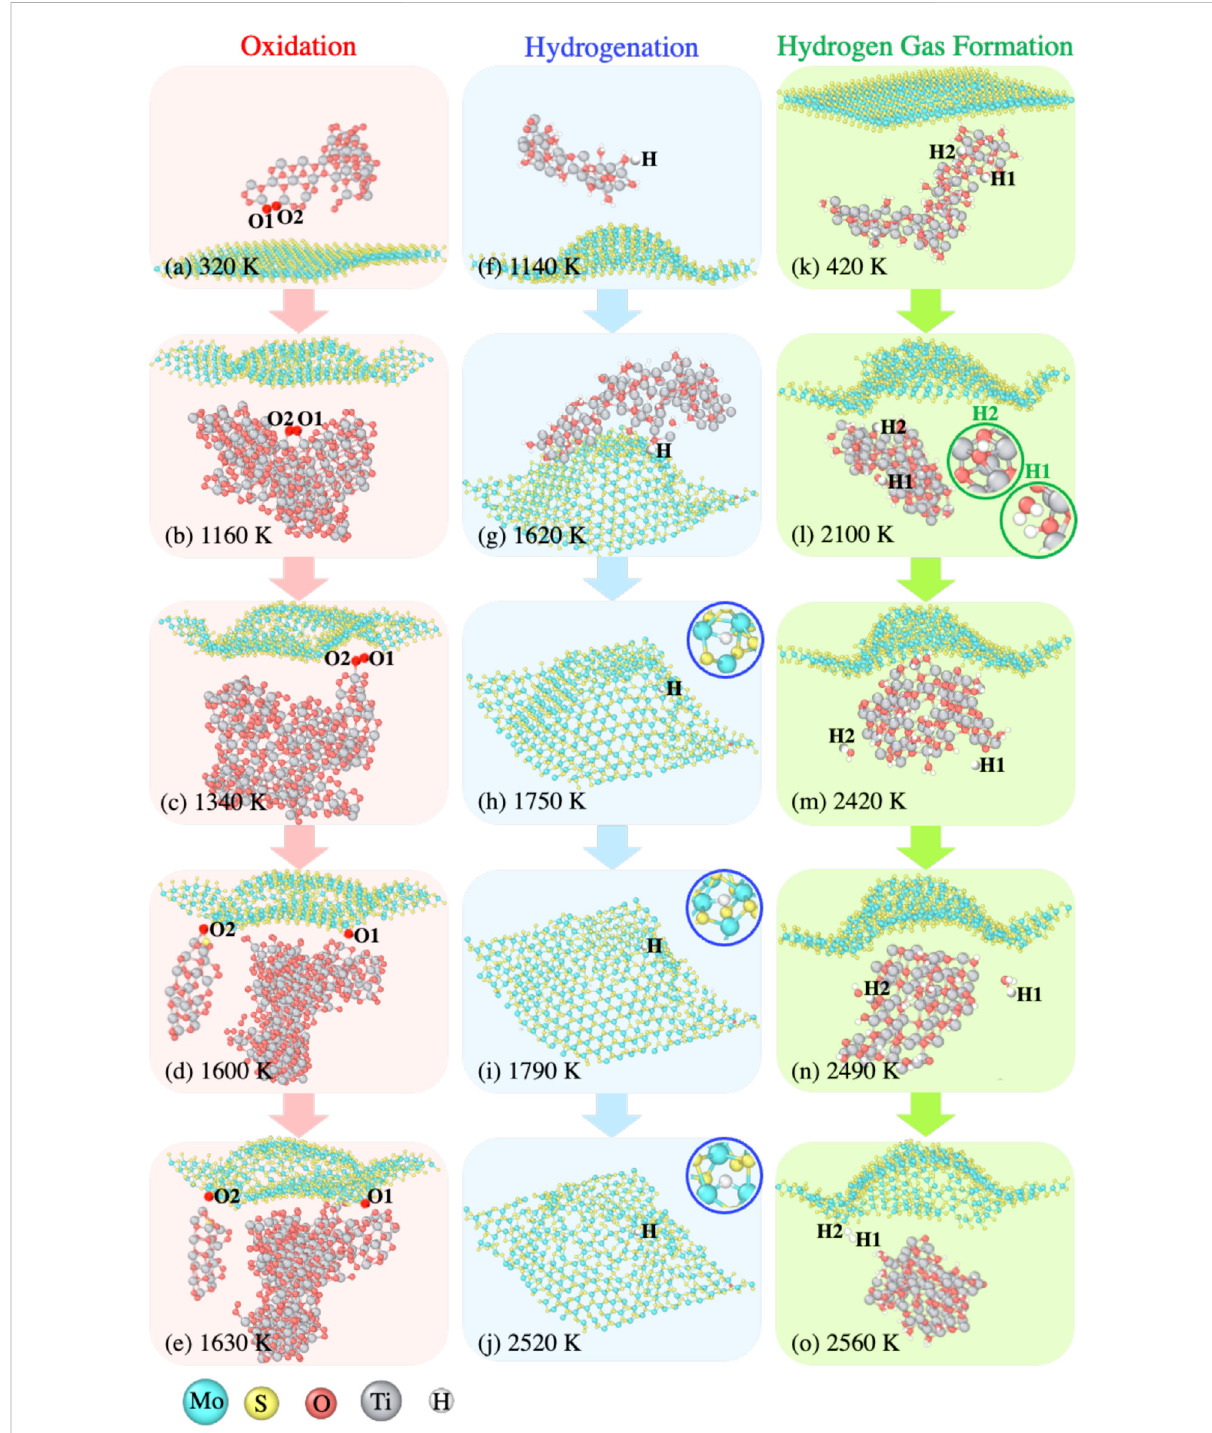
FIGURE 7 Representative reaction pathways during the temperature ramp, such as (A – E) oxidation of Mo atoms with Ti x O y clusters delivering O radicals drawn from the D-MoS 2 + O 2 + Ti system, (F – J) hydrogenation of Mo atoms with Ti x H y O z clusters delivering H radicals drawn from the D-MoS 2 + H 2 O+ Ti system, and (K – O) hydrogen gas formation with the presence of Ti x H y O z clusters drawn from the D-MoS 2 + H 2 O+ Ti